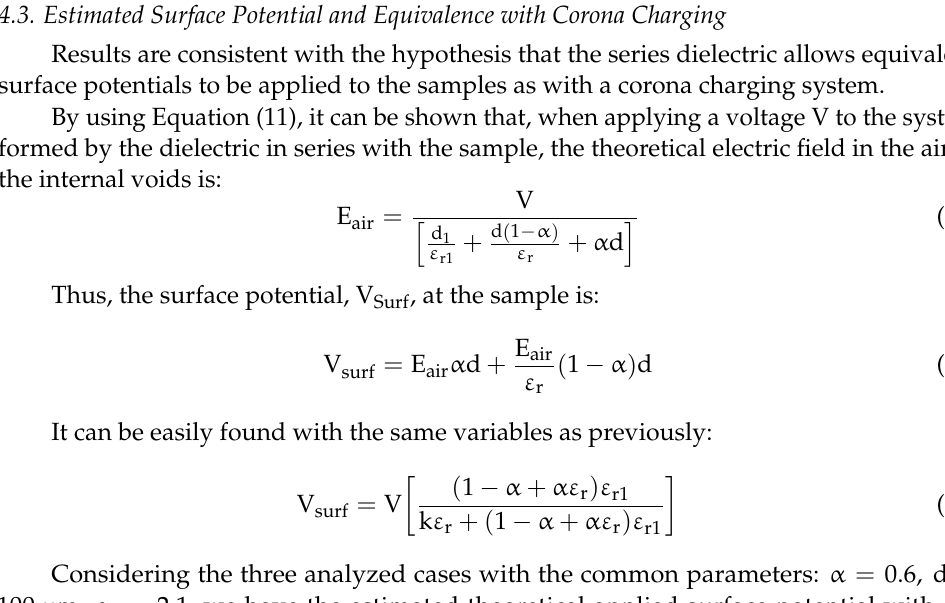
Figure 10. Example of spatial distribution of d 33 constant in a sample charged with an epoxy dielectric layer with an epoxy thickness of 300 μm. The numbers indicate the value of the d 33 constant in the measurement points and the circle the position of the high-voltage electrode.